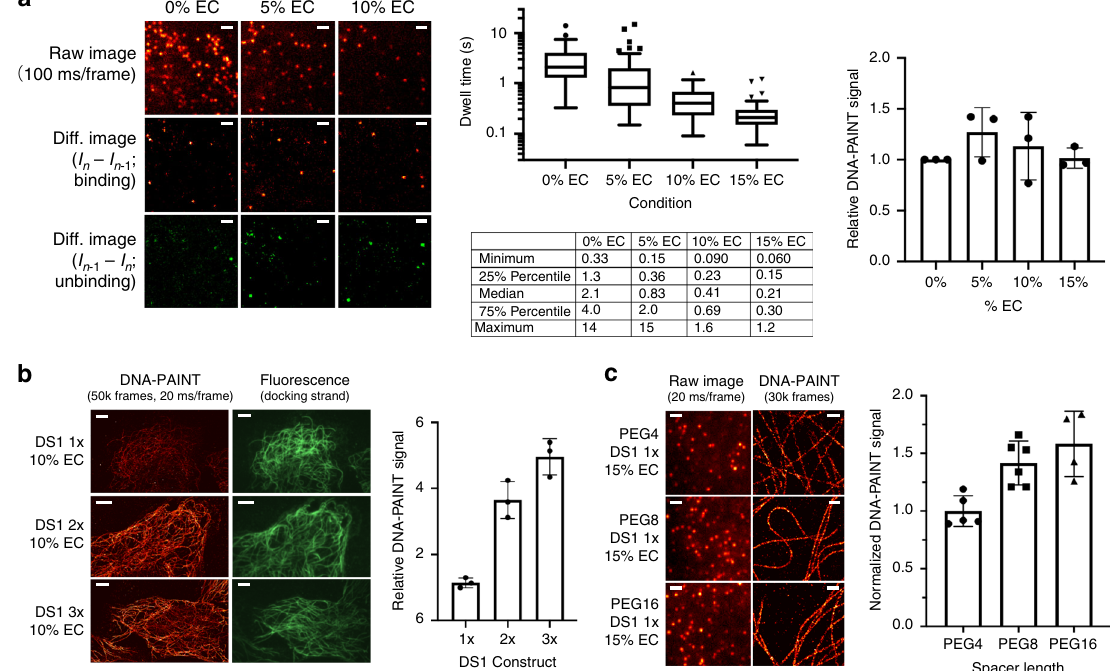
Fig. 2 Accelerating DNA-PAINT with E, R, and S. a EC accelerates DS-IS unbinding. First panel, single-molecule images of the same sample region at different EC concentrations (top) and the corresponding difference images for binding (the current frame minus the preceding frame; middle) and the reverse (unbinding; bottom). Middle panel shows dwell time ( τ on; plot at the top and key statistics at the bottom) at different EC%. Right panel shows the sorted number of localizations normalized to that at 0% EC. Images were acquired on U2OS cells labeled for microtubules using 0.25 nM IS1-CF660R at a low power density (~100 W cm − 2 ) to minimize photobleaching. Three regions from two independent samples were analyzed at each EC concentration. b Sequence repeats speed up DS-IS hybridization. Left, exemplary images of microtubules in U2OS cells using DS1 with 1x (top), 2x (middle), and 3x (bottom) repeats, showing reconstructed DNA-PAINT images (left column) and epi- fl uorescence images of Cy3-DS1 (right column). Right, DNA-PAINT signal normalized to the corresponding DS signal, at 1.1 ± 0.1, 3.7 ± 0.6, and 5.0 ± 0.6 (mean ± SD) for DS1 1x, 2x, and 3x, respectively. DNA-PAINT images were acquired in ~17 min (50,000 frames at 20 ms per frame) using 0.2 nM IS1-CF660R and 10% EC. Results from three experiments were analyzed. c Spacer between DS and antibody improves IS-DS binding. Left panel, example single-molecule images (left) and reconstructed DNA-PAINT images (right) of microtubules in U2OS cells using DS1-antibody conjugates with a PEG4 (top), a PEG8 (middle), or a PEG16 (bottom) spacer. Images were acquired in 10 min (30,000 frames at 20 ms per frame) using 2 nM IS1-CF660R and 15% EC. Right panel, total DNA-PAINT signals normalized to that using DS1-PEG4-antibody, showing 1.0 ± 0.1, 1.4 ± 0.2, and 1.6 ± 0.3 (mean ± SD) for PEG4, PEG8, and PEG16, respectively. Four to six regions of interest from two independent experiments were sampled for each spacer length. All error bars are SD. Scale bars are 2 µ m in ( a ), 5 µ m in ( b ), 2 µ m in ( c , left panel, left column), and 500 nm in ( c , left panel, right column). Source data underlying Fig. 2a – c are provided as a Source Data fi